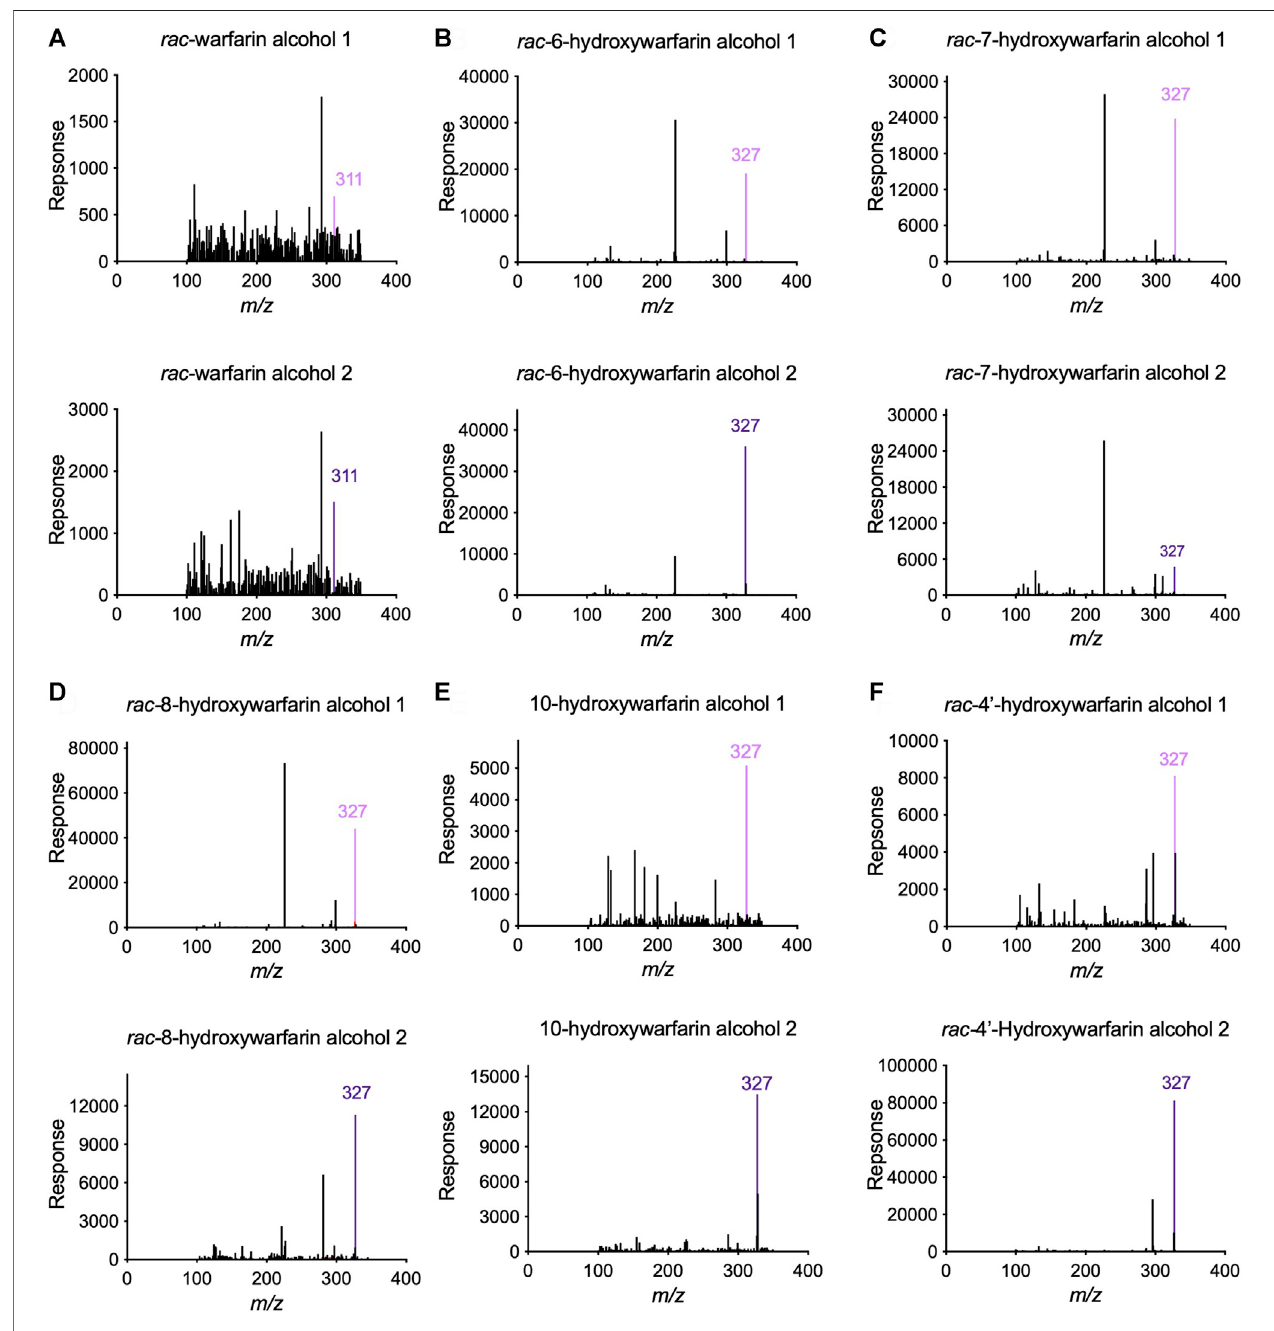
FIGURE4| Tandem MassSpectrometry (LC-MS/MS)analysiscon fi rmedthepredicted masses ofthereducedhydroxywarfarinmetabolites withreducedwarfarin as a control. Parent mass scans were conducted for the metabolites from cytosolic reduction reactions for (A) rac -warfarin, (B) rac -6-hydroxywarfarin, (C) rac -7- hydroxywarfarin, (D) rac -8-hydroxywarfarin, (E) 10-hydroxywarfarin isomer mixture, and (F) rac -4 ′ -hydroxywarfarin. Each panel includes the mass spectrum for alcohol 1(top)andalcohol2(bottom). Thecoloredlineindicatestheexpectedandobserved311 m /z forwarfarinalcohol1(lightpurple)andalcohol2(darkpurple) andthe expected and observed 327 m /z for hydroxywarfarin alcohol 1 (light purple) and alcohol 2 (dark purple), respectively.